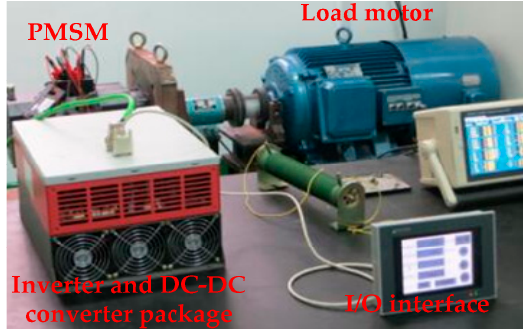
Figure 10. Experimental platform of the permanent magnet synchronous motor (PMSM)